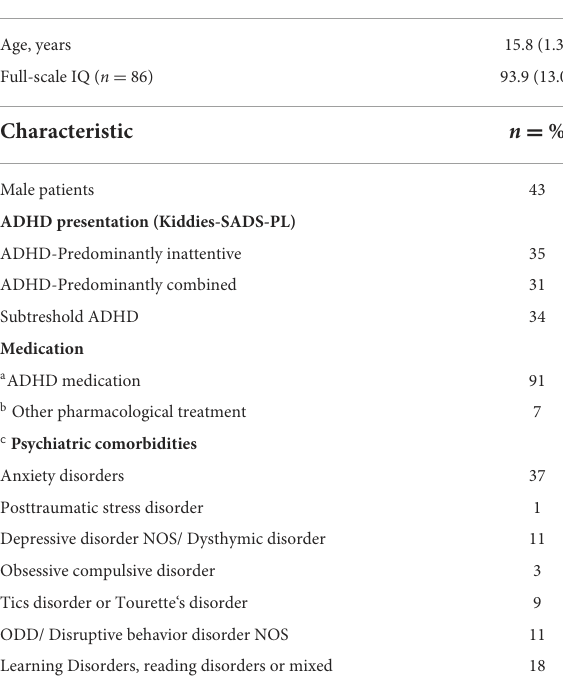
impairment predict anxiety in a clinical adolescent population. TABLE 1 Characteristics of the participants ( n =